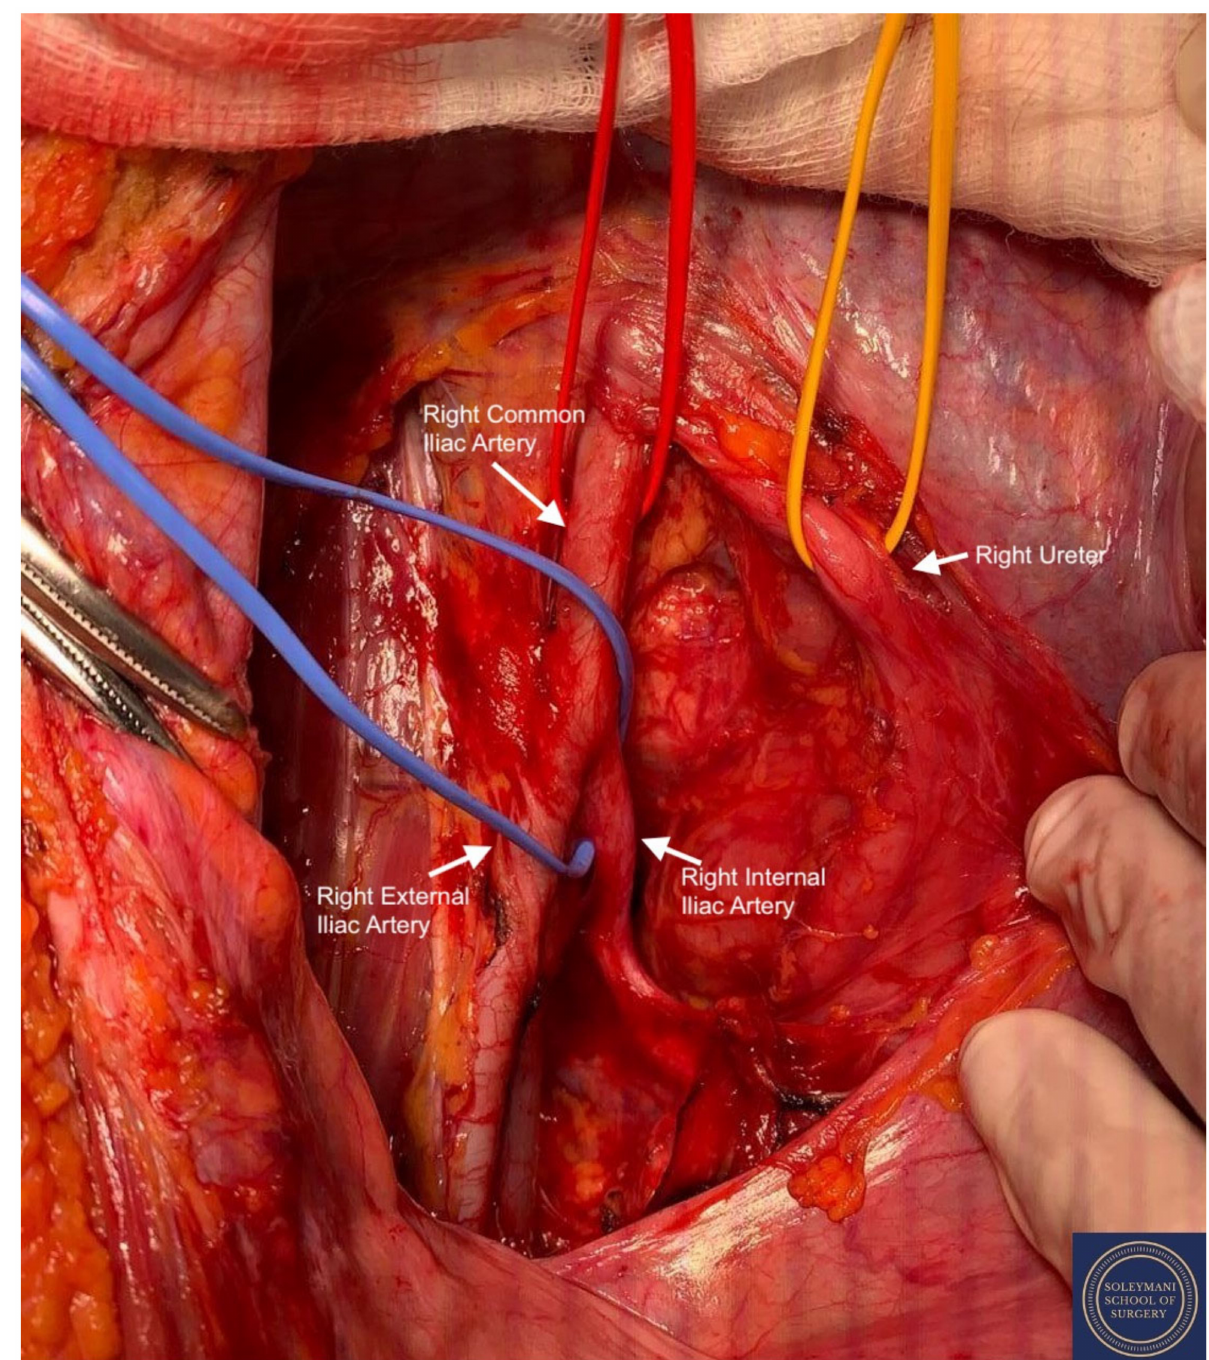
Figure 6. Exposure of the right pararectal space with isolation of the following structures: Red Sling = right common iliac artery, Yellow Sling = right ureter, Blue Sling = right internal iliac